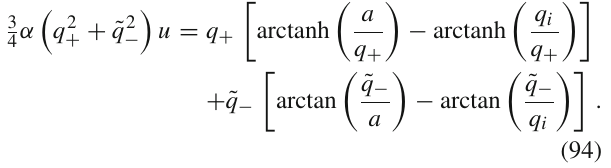
Fig. 2 Left panel: The evolution of the scalar function a ( u ) for the four dimensional solution with k 0 = 1 and γ 2 < 0. We have set γ 2 = √ − 1 ,α = 5 , c = 7 √ , Q = 4 11 so that ˆ q − = 1 , q + = 2. The red 15 point denotes the initial scalar charge q i = 1 . 1 > ˆ q − . Right panel: The evolution of the apparent horizon. We further set g = 1 ,γ 1 = − 10 / 9.